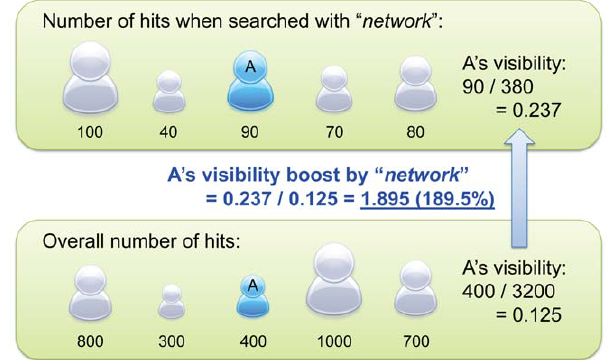
Figure 2. An example of ‘‘visibility boost’’ calculation. This figure shows how to calculate the visibility boost by research topic ‘‘network’’ for the researcher A in the middle (blue).